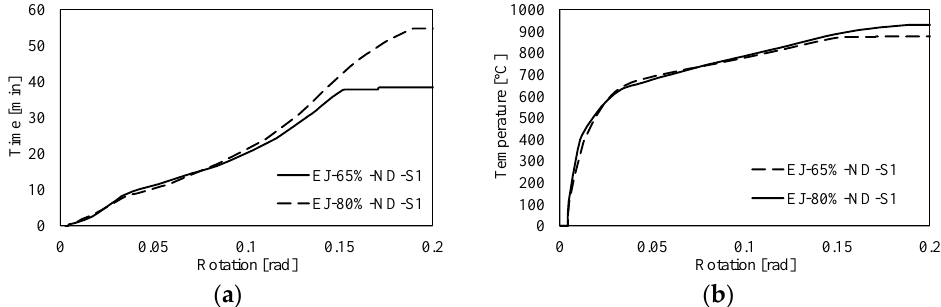
Figure 9. Comparison between the external RBS-65 and RBS-80 joints in terms of time-rotation ( a ) and temperature-rotation ( b ) curves.